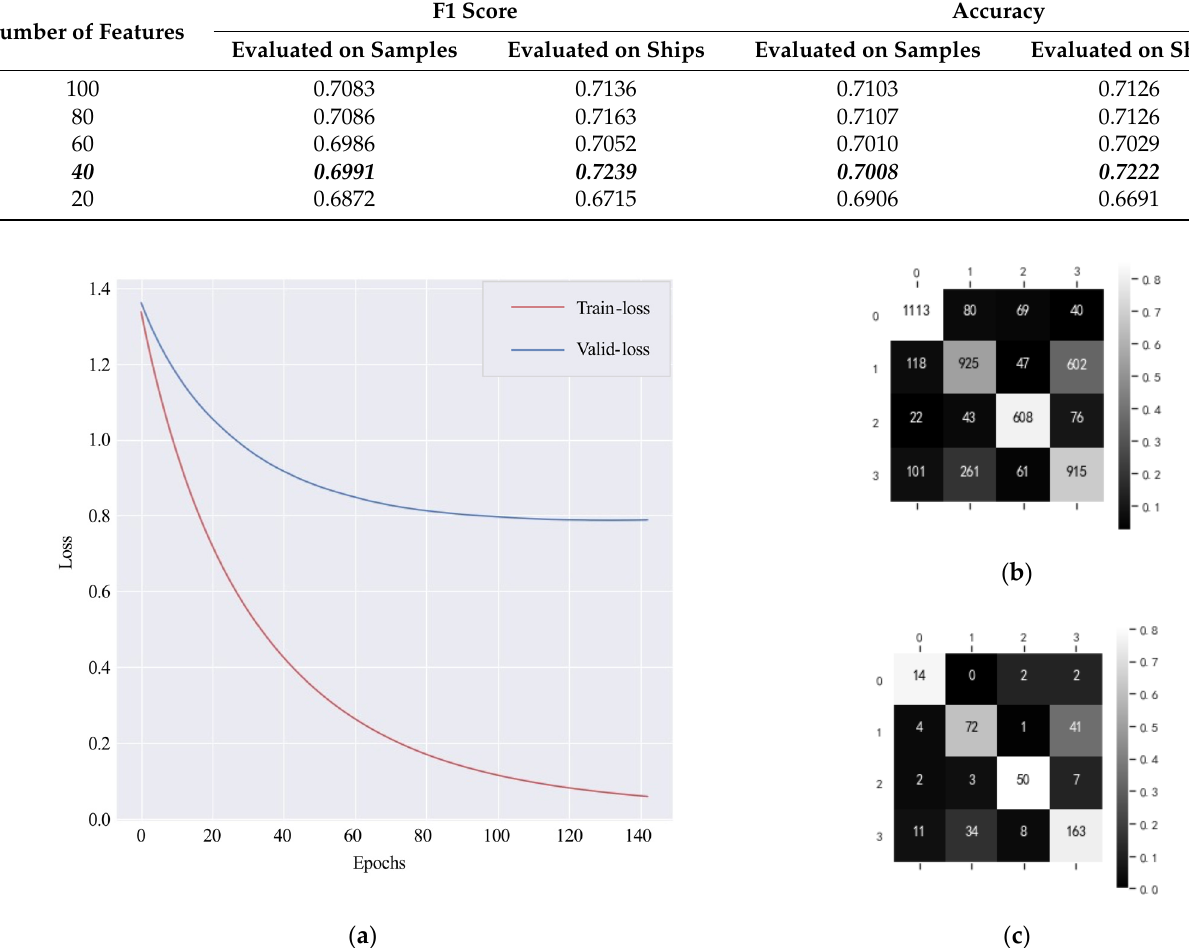
Figure 27. ( a ) Learning curve (XGBoost2); ( b ) Confusion matrix of samples (XGBoost); ( c ) Confusion matrix of ships (XGBoost2).